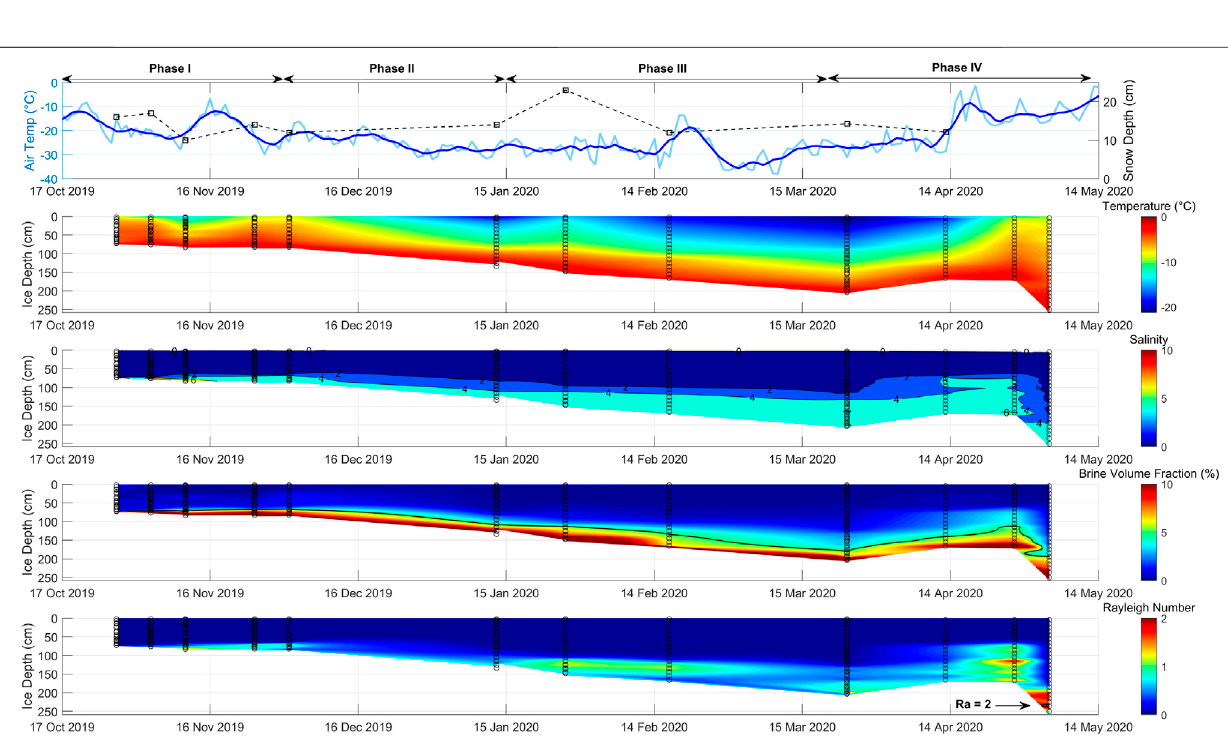
Frontiers in Earth Science |